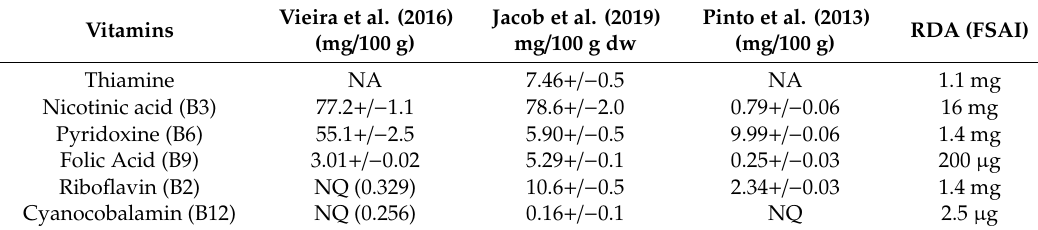
Table 3. Vitamin Composition of BSY